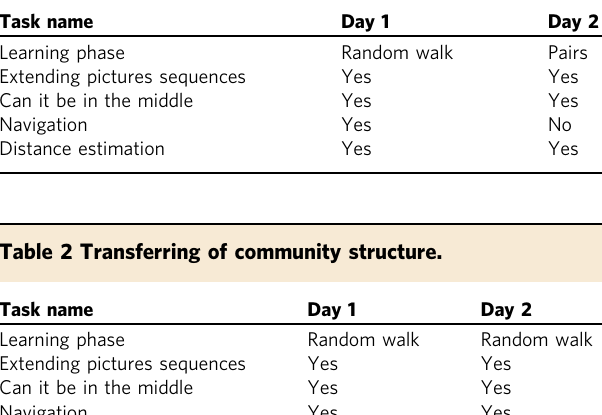
Table 1 Transferring of hexagonal structure.